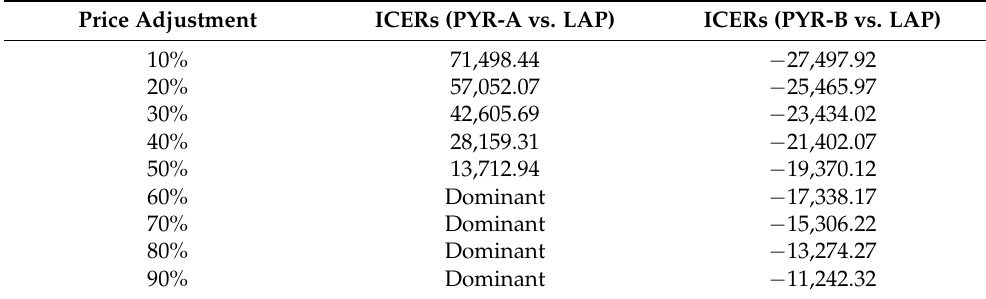
Table 3. Scenario analysis results in price reductions relative to pyrotinib and lapatinib.